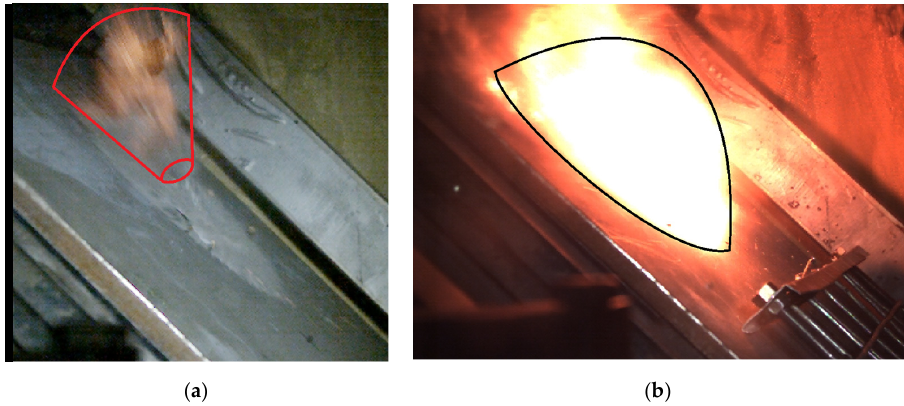
Figure 11. ( a ) Semi-conical shape of the thermal energy propagation of the 7.62 × 51 mm SWISS PAP projectile; ( b ) Hemispherical shape of the thermal energy propagation of the 7.62 × 51T projectile.